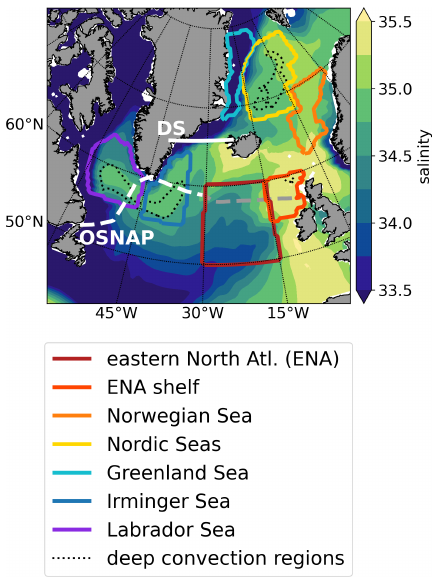
Figure 8. Map of regions selected for computing water properties and mixed-layer statistics. All regions are defined by geographic coordinates. Shelf regions are excluded by prescribing a minimum depth of 1500m for the Nordic, Irminger, and Labrador seas and of 1000m for the Norwegian Sea. The ENA shelf region excludes areas shallower than 100m. In contrast, the Greenland Sea region is defined for areas shallower than 500m. White lines indicate the Denmark Strait (DS, solid) and Overturning in the Subpolar North Atlantic Program (OSNAP, Lozier et al., 2019) (dashed) cross- sections. For reference, the long-term mean salinity of the coupled simulation averaged over the top 200m is shown (cf. Fig. 5a) along with the March-mean 500m mixed-layer depth contour because these quantities guided the region selection.